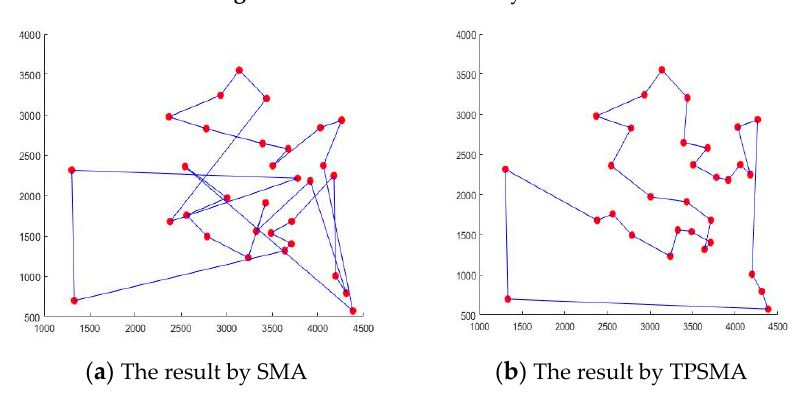
Figure 5. The simulation of ulysses16.